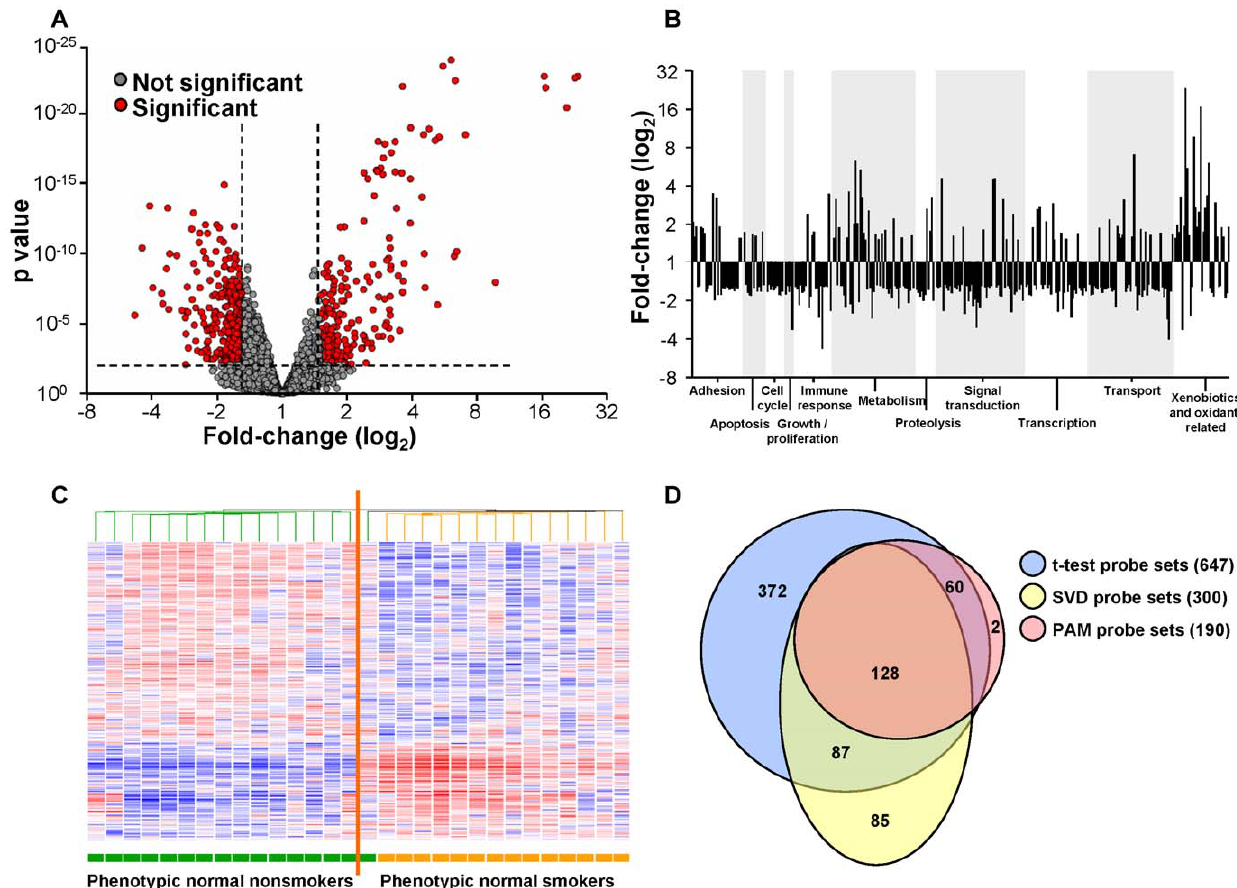
Figure 1. Differential gene expression profiles in the small airway epithelium in nonsmokers and healthy smokers. Expression levels normalized by array were compared for n=58 healthy smokers and n=47 healthy nonsmokers for all probe sets ‘‘present’’ in at least 20% of samples. A. Volcano plot. The mean expression level for healthy smokers vs healthy nonsmokers was assessed for fold-change (abscissa) vs p value (ordinate) by t-test. Each probe set is represented by a filled circle, with probe sets that are not significantly different in healthy smokers compared to healthy nonsmokers in gray and those that are significantly different in the 2 groups in red. Probe sets with a higher expression level in healthy smokers are to the top right and those with a lower expression level in healthy smokers are to the top left. There are 647 probe sets representing 375 known genes that are significantly up- and down-regulated by smoking. Only probe sets corresponding to known genes were used to construct the index for small airway epithelium gene expression (I SAE ). When there is more than one probe set for a given gene, the decision as to which probe set is used for further analysis was made as described in Methods. B. Categories of genes differentially modified by smoking in the small airway epithelium. Shown is a skyscraper plot of fold-changes (log 2 scale) for probe sets significantly differentially expressed in healthy smokers vs nonsmokers. Known genes significantly up-regulated in healthy smokers have fold-changes . 1; those significantly down-regulated in healthy smokers have fold-changes , 1. Alternating gray and white bands highlight the probe sets belonging to specific functional categories. C. Unsupervised cluster analysis. Probe sets expressed above average are represented in red, below average in blue, and average in white. Each row represents one of the 375 smoking- responsive genes used in the index, and each column represents an individual subject from the validation set of healthy nonsmokers and healthy smokers. Healthy smokers (n=14) are indicated by orange, healthy nonsmokers (n=16) by green. D. Venn diagram. Smoking-responsive probe sets identified by the main, t-test analysis (647 probe sets) are represented in blue, probe sets identified by singular value decomposition (SVD, 300 probe sets) in yellow, and probe sets identified by prediction analysis of microarrays (PAM, 190 probe sets) in pink. The intersection of the ovals represents the overlap between genes selected using each method, i.e., 87 genes are smoking-responsive in the t-test and SVD analyses (green), 60 probe sets overlap between the t-test and PAM analyses (purple), and 128 genes were significant in all 3 analyses (brown).